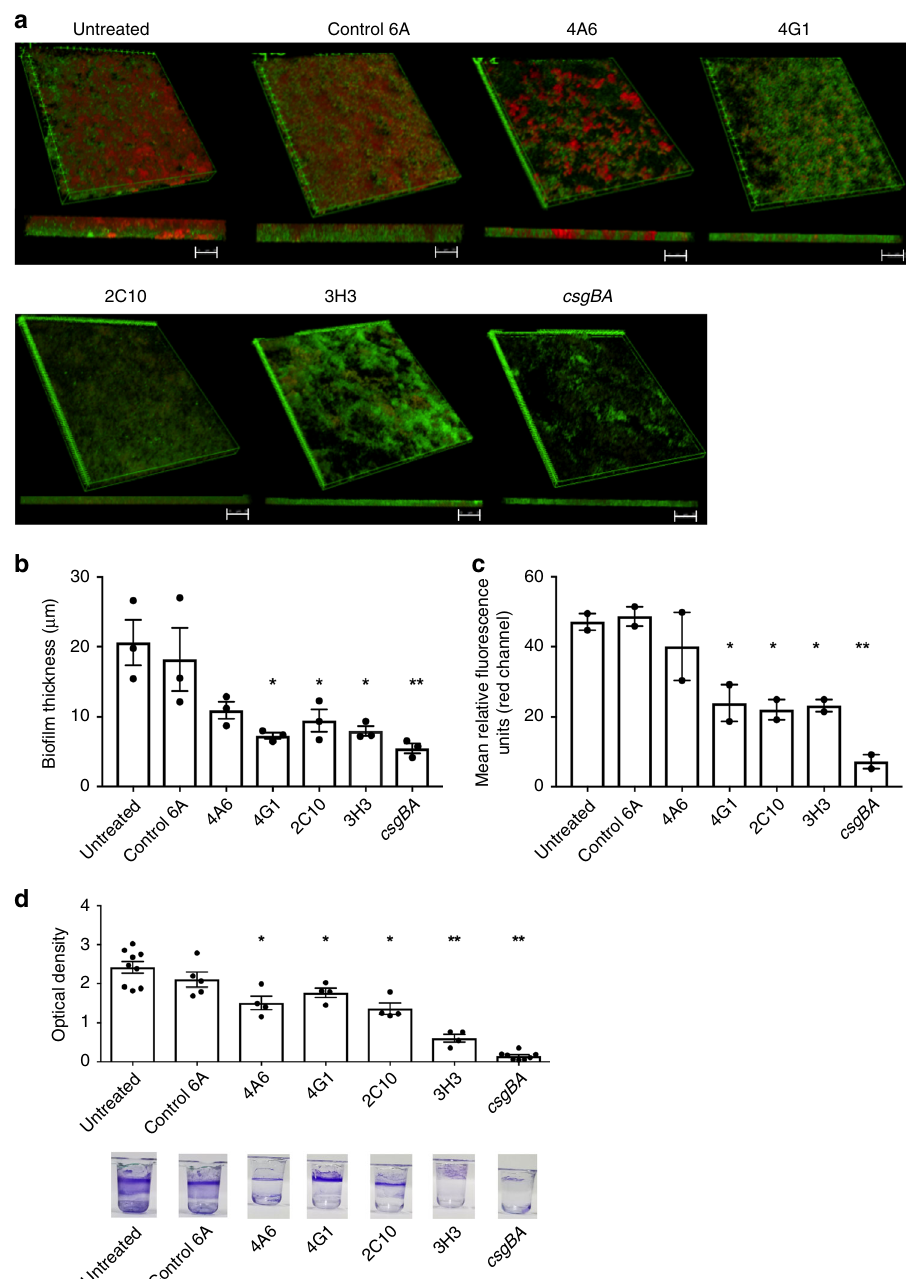
Fig. 1 Incubation of S . Typhimurium bio fi lms with anti-amyloid mAbs reduces bio fi lm thickness and curli content. a S . Typhimurium was cultured in the absence of mAb (untreated) or in the presence of 0.5 mg/ml control antibody 6A or 0.5 mg/ml 4A6, 4G1, 2C10, or 3H3. Isogenic mutant S . Typhimurium csgBA was included as a negative control. After 72 h, bio fi lms were stained with the bacterial stain Syto9 (green) and amyloid stain Congo Red (red), washed extensively, and imaged using a Leica TCS confocal microscopy at ×63. ImageJ was used to create 3D reconstructions of z-stacks using the 3D projection application. Scale bars represent 25 μ m. b Bio fi lm thickness ( μ m) was determined from z-stacks using Leica TCS software. c Mean relative fl uorescent units (RFU) of the red channel calculated from z-stacks using ImageJ. d Bio fi lms were grown in the absence (untreated) of antibody or in the presence of 0.5 mg/ml 6A, 4A6, 4G1, 2C10, or 3H3. csgBA was included as a negative control. After 72 h, bio fi lms were stained with crystal violet, and the optical density at 570 nm was determined. Representative images of crystal violet staining are shown below the graph. Mean and SE were calculated from results from at least two independent experiments. * p < 0.05, ** p < 0.01 as determined by Student ’ s t